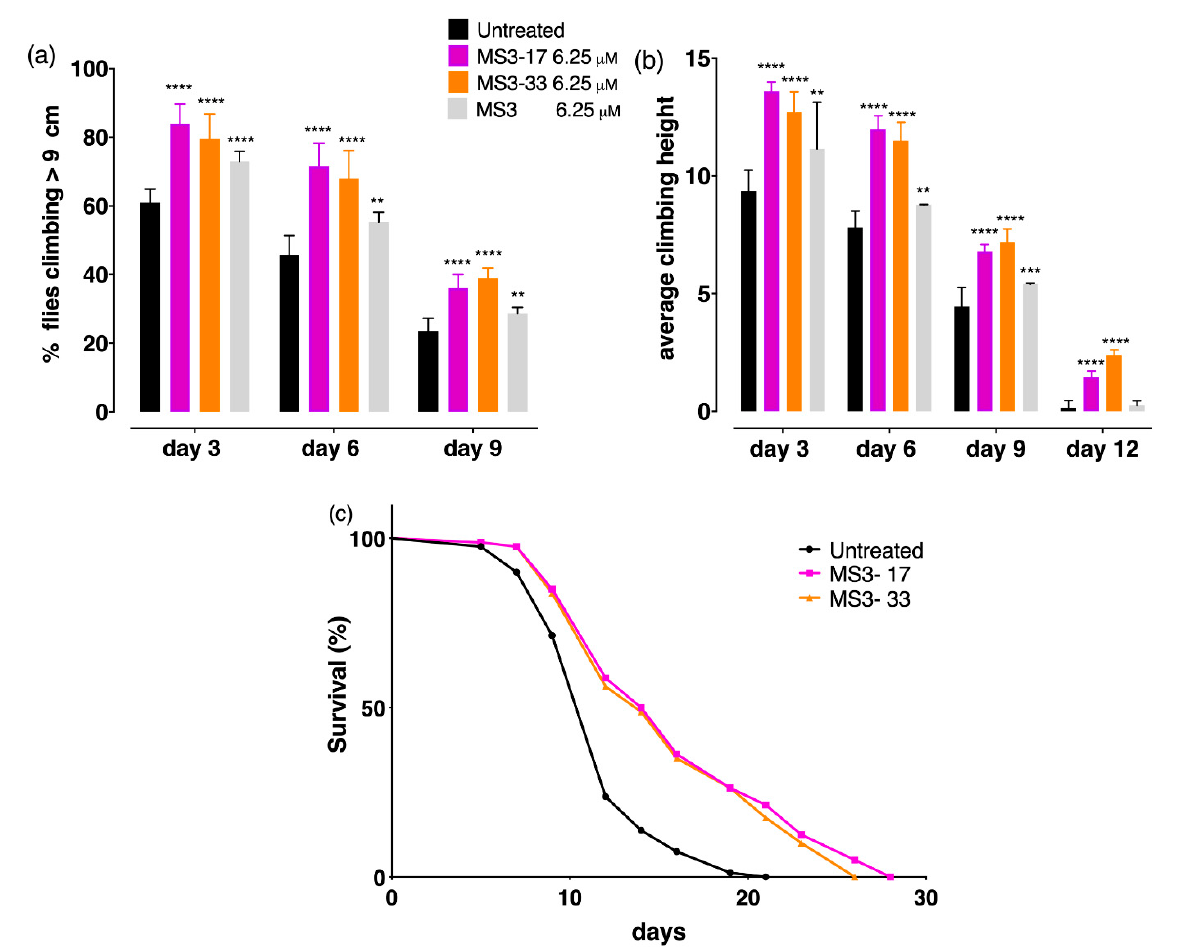
Figure 10. MS3-derived aptamers’ suppressed HD symptoms in a Drosophila model. Administra- tion of MS3 and of its two analogues (MS3-17 and MS3-33) during adult period suppressed motor dysfunction in flies expressing HttFLQ128. Comparison was made between untreated and treated flies of the same age. ( a ) Climbing assay. The percentage of flies that, after the MS3 analogues’ (MS3-17 and MS3-33) chronic treatment throughout adulthood, could reach the 9 cm target was higher than both untreated and MS3-treated sibling flies at each point examined. ( b ) The average climbing height of MS3 analogues was significantly higher compared with MS3-treated flies also on day 12 after eclosion. ( c ) The survival curves of both treated groups declined slower in comparison with the curve of the untreated flies that quickly dropped on day 7, and the mean and maximum lifespan were significantly extended compared with untreated flies. **** p < 0.0001; *** p = 0.0005; ** p = 0.023, compared with untreated flies. Data represent mean +/ − SD.